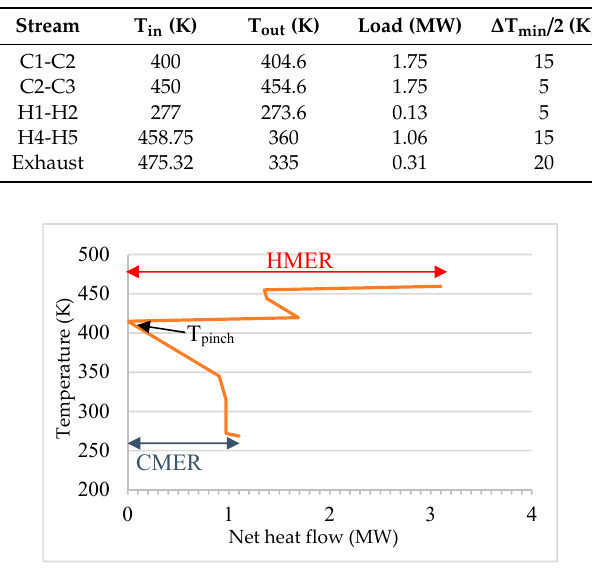
Figure 7 . Pinch analysis of the base case study Figure 7. Pinch analysis of the base case